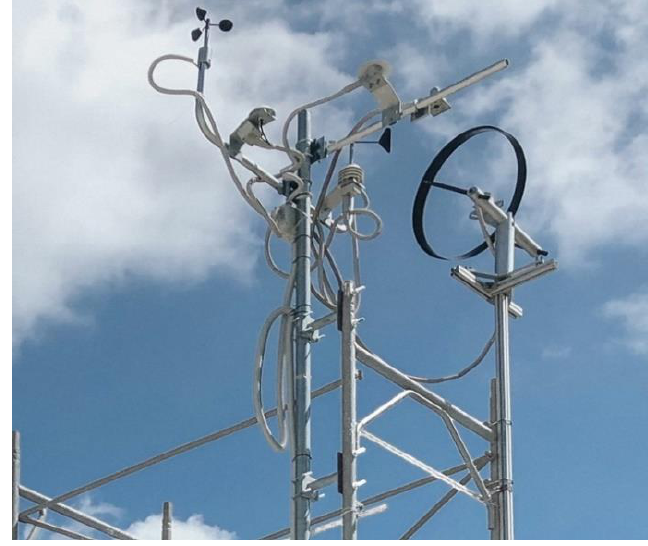
Figure 1. The weather station used to monitor the real outdoor conditions.